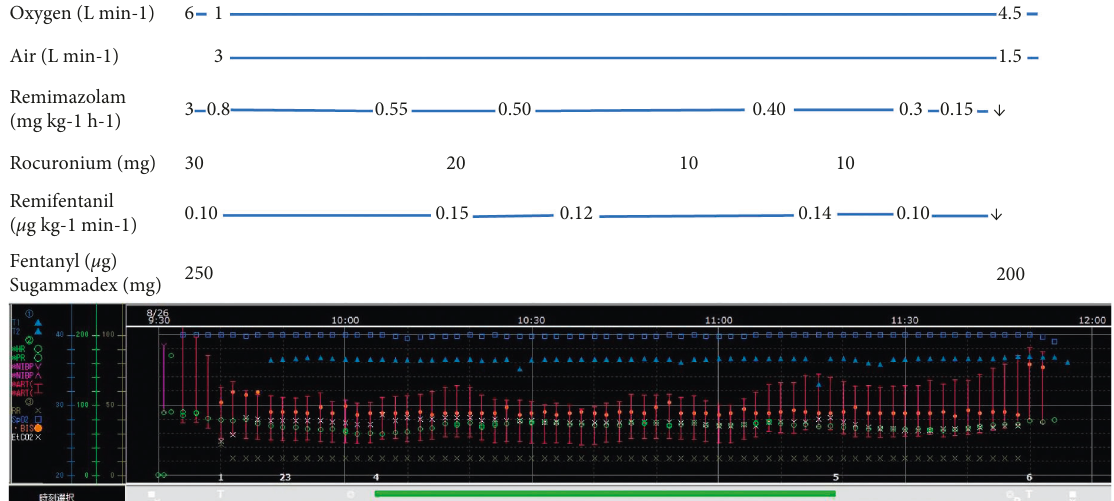
Figure 1: Anesthetic chart of this case. The anesthetic chart recorded by Prescient ORFujifilm Medical Corporation, Tokyo, Japan. T1: body temperature; HR: heart rate; PR: pulse rate; NIBP: noninvasive blood pressure; ART: arterial pressure (invasive); RR: respiratory ratio; SpO2: oxygen saturation; BIS: Bispectral Index; EtCO2: end-tidal carbon dioxide; ■ : in operation room and out operation room; × : start of anesthesia and end of anesthesia; T: intubation and extubation; ◎ : start of operation and end of the operation; R: Sugammadex reverse